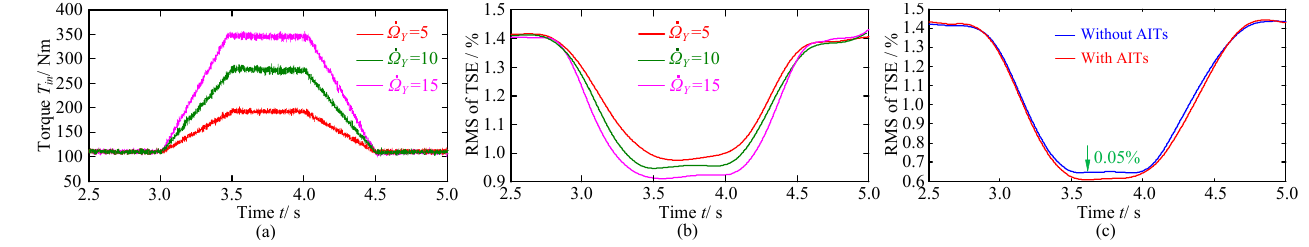
Figure 21. Relative influence proportion of each factor: ( a ) displacement response in x -direction; ( b ) displacement response in y -direction; ( c ) displacement response in z -direction.